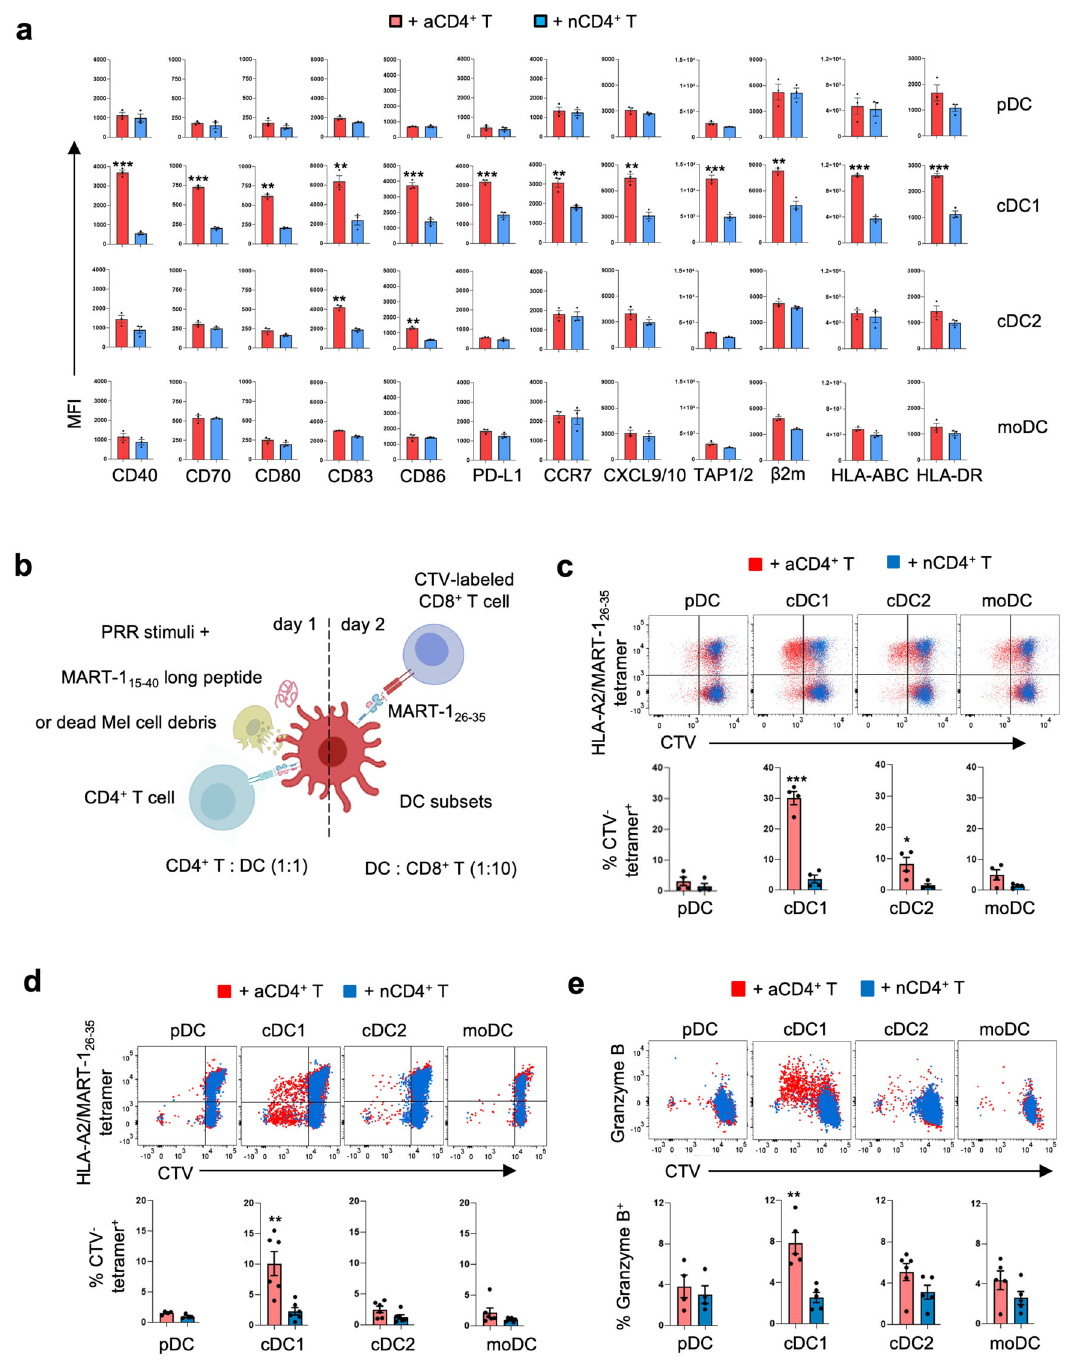
Fig. 2 | Human cDC1 is superior to other DC types in relaying CD4 + T-cell help fortheanti-tumorCTLresponse.a ThepDC,cDC1,cDC2andmoDCsubsetswere fl ow cytometrically isolated and co-cultured with activated (a)- or naive (n)CD4 + T-cells for 12hasoutlined in SupplementaryFig. 5Next,key moleculesofthecDC1 “ help ” signature were analyzed by fl ow cytometry. Median Fluorescence Intensity (MFI) quanti fi cations are shown for indicated markers expressed by DC subsets under indicated conditions. Data were pooled from three independent experi- ments ( n =3) with technical duplicates. b Schematic depiction of the tumor antigen-speci fi c CTL priming system. On day 1, pDC, cDC1, cDC2 and moDC from HLA-A2 + healthydonorswereincubatedwithactivated(a)-ornaïve(n)CD4 + T-cells, loadedwithMART-1 15-40 longpeptide ordeadMART-1 + melanomacelldebrisand a mixtureofPRRstimuli.Onday2,T SCM phenotypeCD8 + Tcellswereaddedthathad